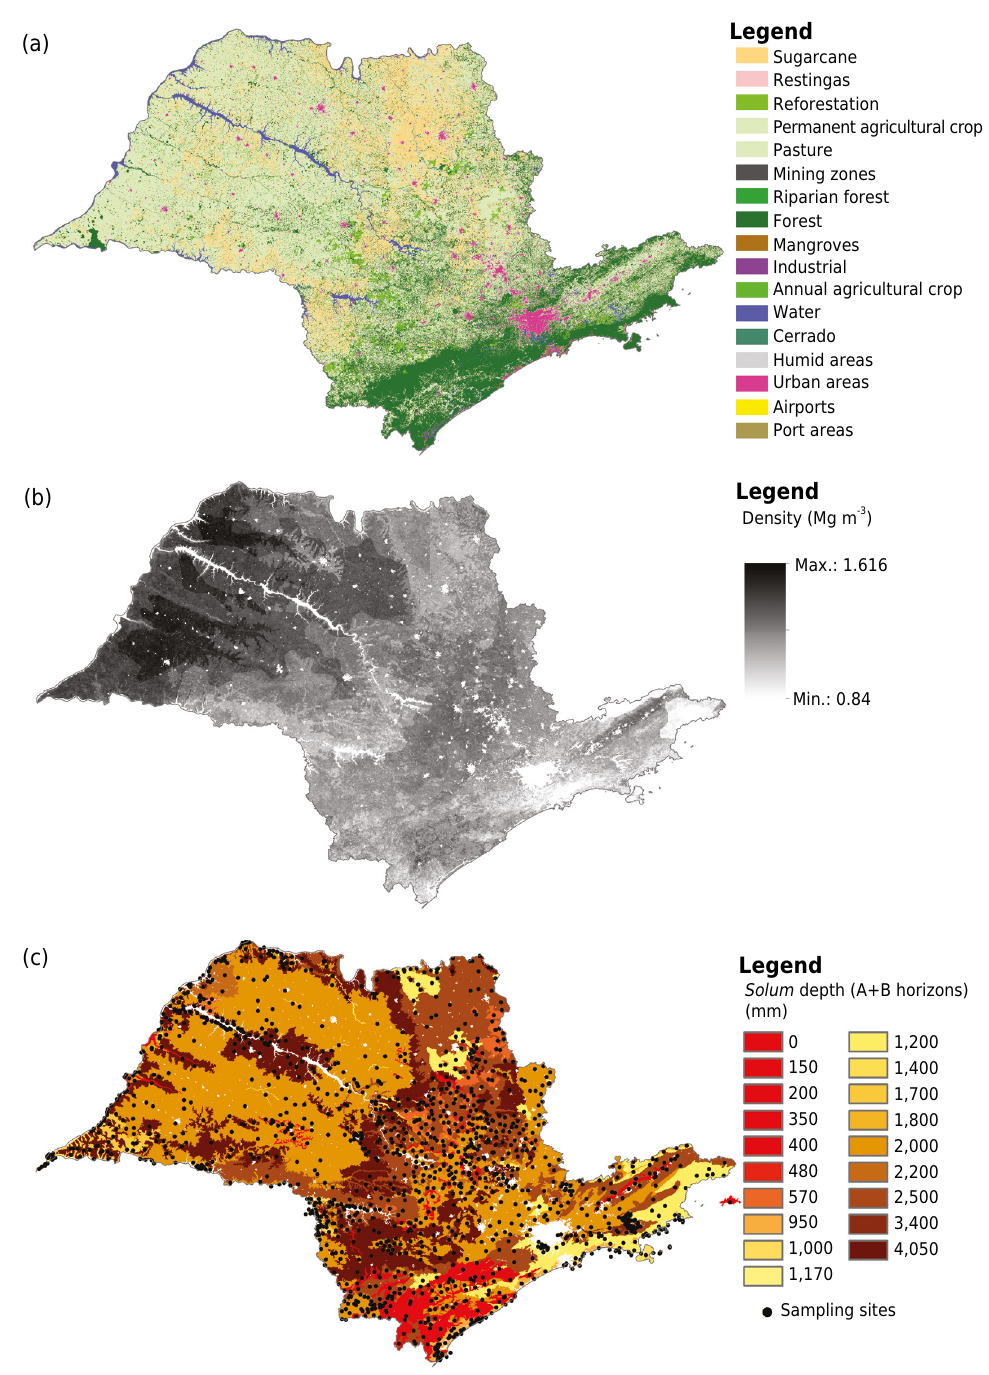
Figure 2. Data used: (a) Land use map of 2005; (b) Soil density map and (c) Soil depth map obtained by interpolation of data of Oliveira